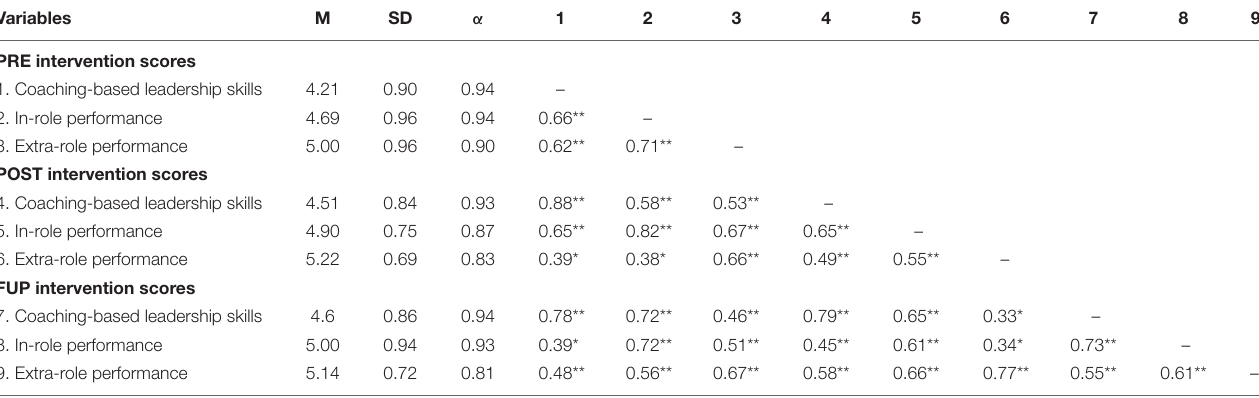
Correlations; **p < 0.01; *p < 0.05.